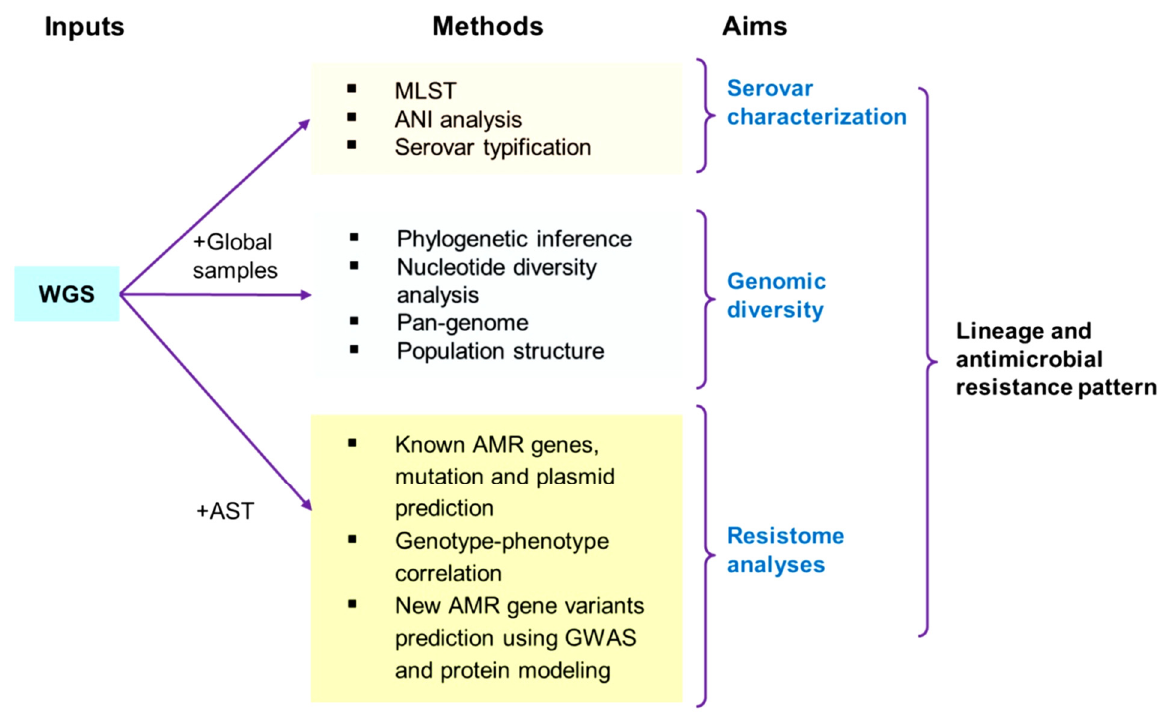
Figure 1. The overview of methods and objectives of this study.